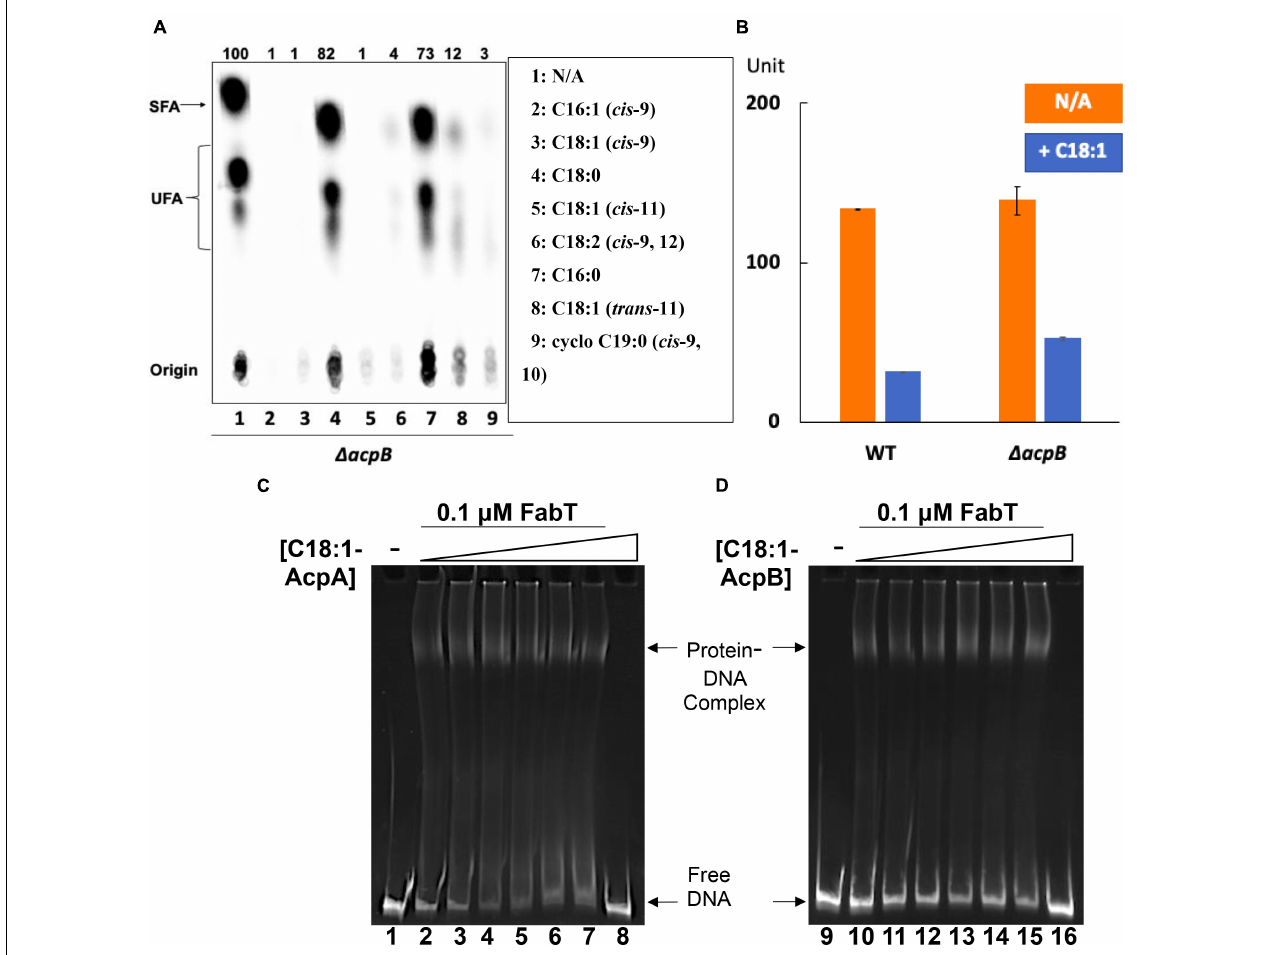
FIGURE 8 | Enterococcus faecalis acyl-AcpA enhances FabT promoter binding in regulation of fatty acid synthesis. (A) E. faecalis (cid:49) acpB strain de novo fatty acid synthesis in the presence of exogenous fatty acids. (B) The effects of oleic acid on expression of lacZ gene from fabT promoter in the E. faecalis (cid:49) acpB strain. (C,D) EMSA analysis for comparison of E. faecalis FabT biding to the fabT promoter region in the presence of oleoyl-AcpA (at left) or oleoyl-AcpB (at right). The triangles denote increasing concentrations of acyl-ACP ligands These are (in µ M): 0 for lanes 1, 2, 9, and 10; 0.25 for lanes 3 and 11; 0.5 for lanes 4 and 12; 1 for lanes 5 and 13; 2 for lanes 6 and 14; and 4 for lanes 7, 8, 15, and 16. In panels (C,D) , the binding of FabT to the fabT promoters in the presence of either of the two ligands were processed at the same time and the concentration of DNA promoters used for each situation was the same. But more smears for each lane could be detected in the oleoyl-AcpA lanes, which could lead to lower intensity of free DNA at the bottom. This might also be caused by the different buffers used for preparing oleoyl-AcpA and oleoyl-AcpB, respectively. The oleoyl-AcpB was synthesized and eluted in K-MES buffer (pH 6.1) whereas oleoyl-AcpA was synthesized and